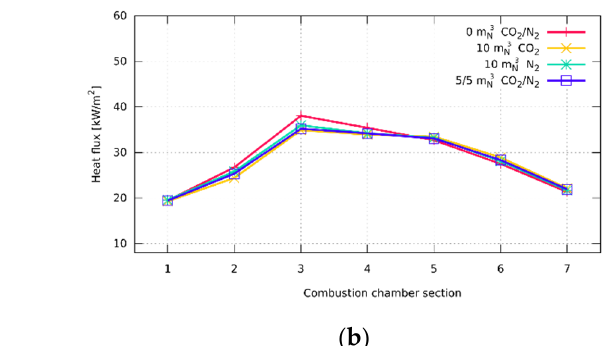
( d ) Figure 12. Influence of inert gas addition on heat flux distribution—burner with staged air distribu- tion—Burner B: ( a ) nitrogen addition—primary regime; ( b ) carbon dioxide addition—primary re- gime; ( c ) nitrogen addition—secondary regime; ( d ) carbon dioxide addition—secondary regime.